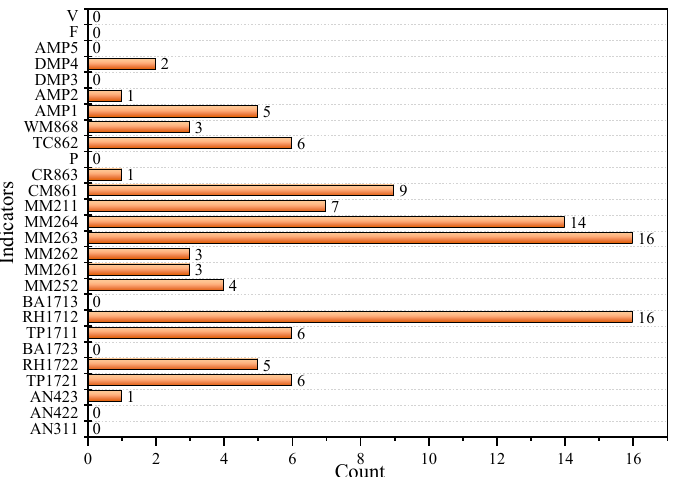
Figure 5. The frequency of each indicator in the top three indicators.